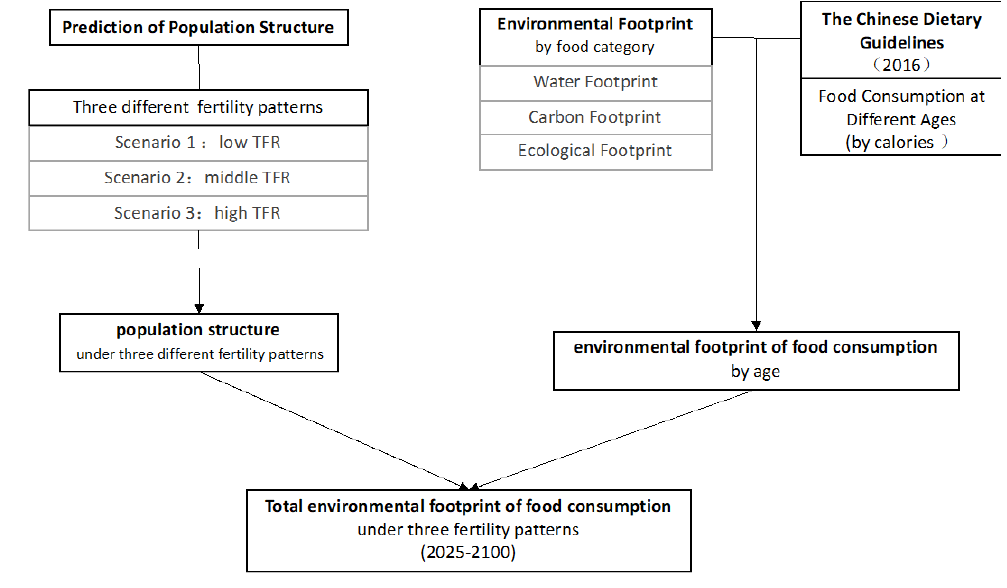
Figure 1. Research framework .